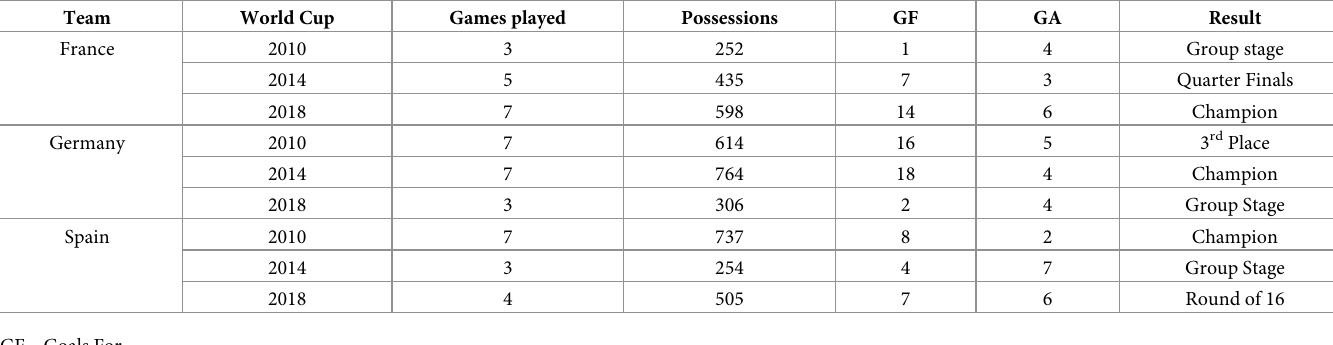
Table 1. Games played, number of possessions, GF, GA and outcome of tournament for France, Germany and Spain in the 2010, 2014 and 2018 World Cups. Team